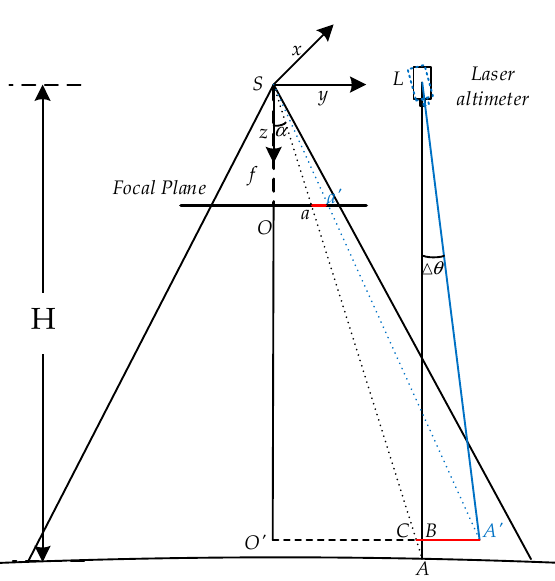
Figure 12. Schematic showing the analysis of the error induced by different capture time.